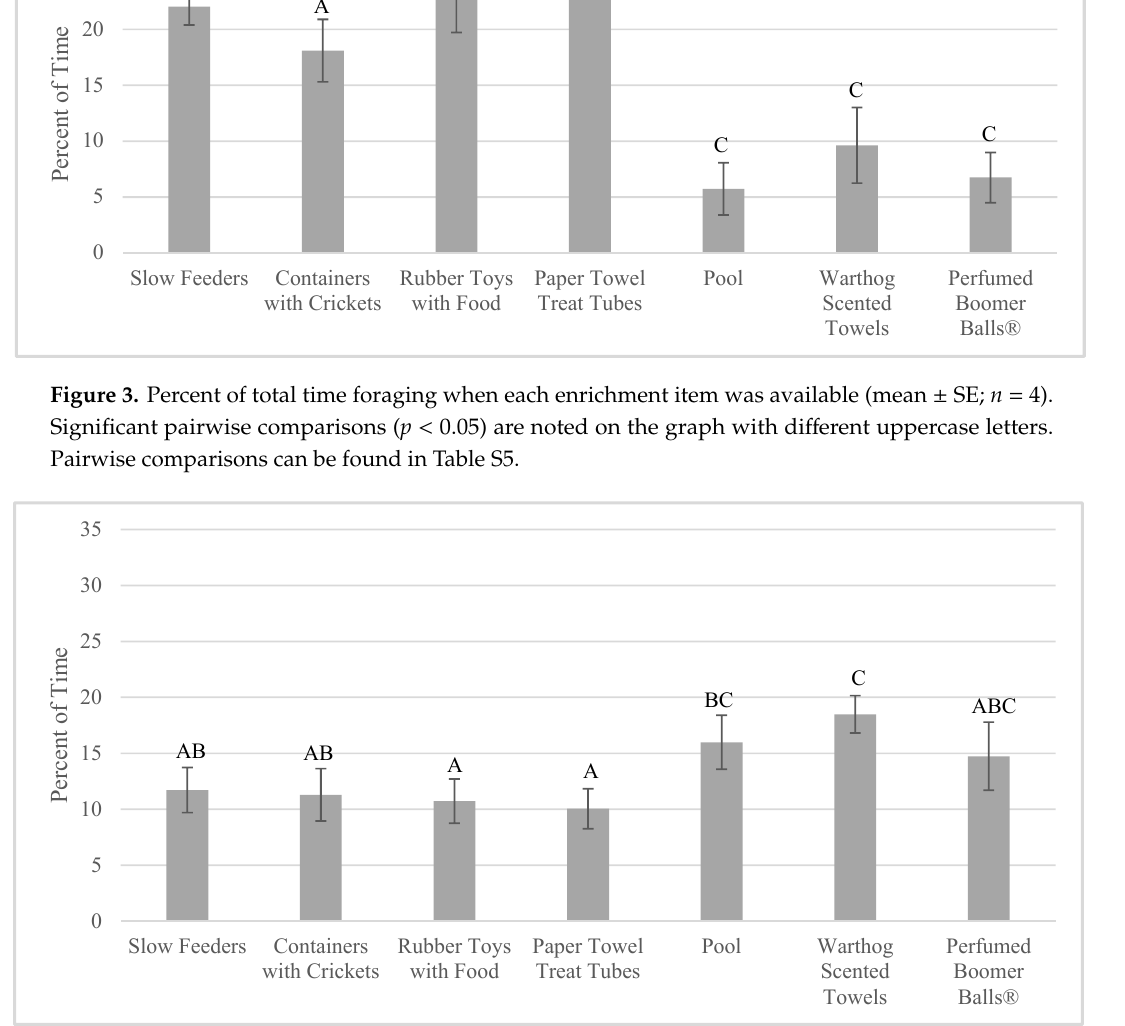
Figure 4. Percent of total time investigating non-food items when each enrichment item was available (mean ± SE; n = 4). Significant pairwise comparisons ( p < 0.05) are noted on the graph with different uppercase letters. Pairwise comparisons can be found in Table S6.